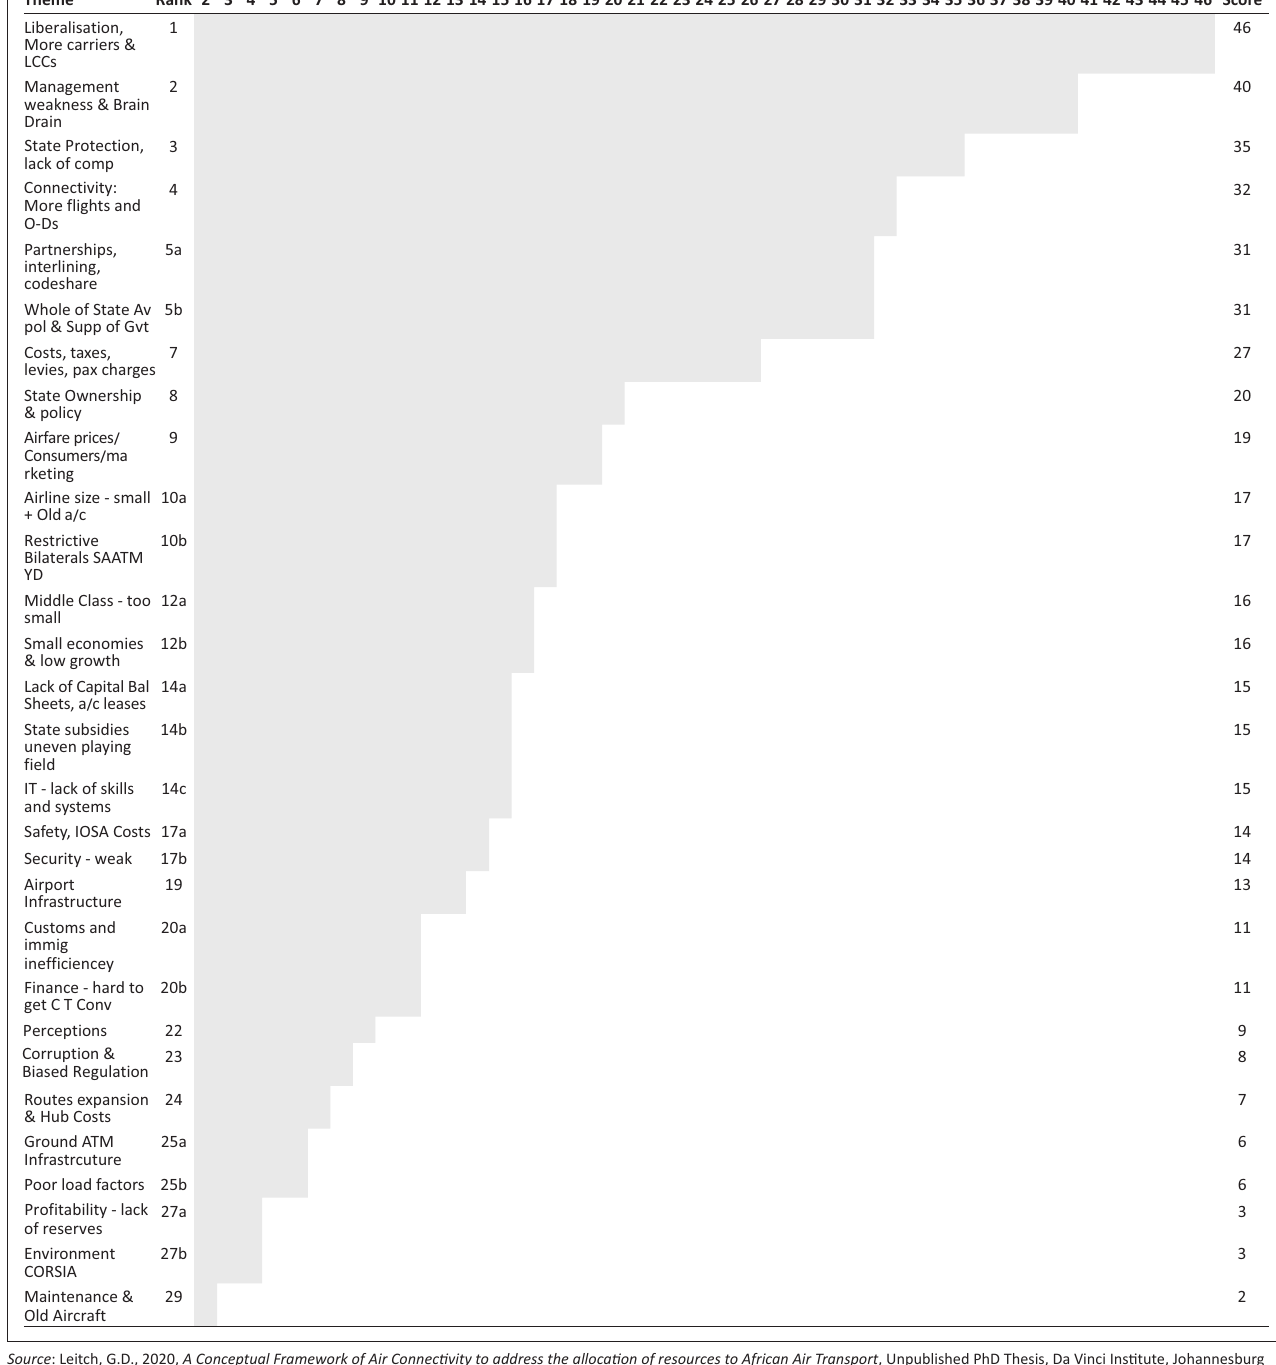
FIGURE 1: Data: Ranked synoptic histogram of theme application – All four data